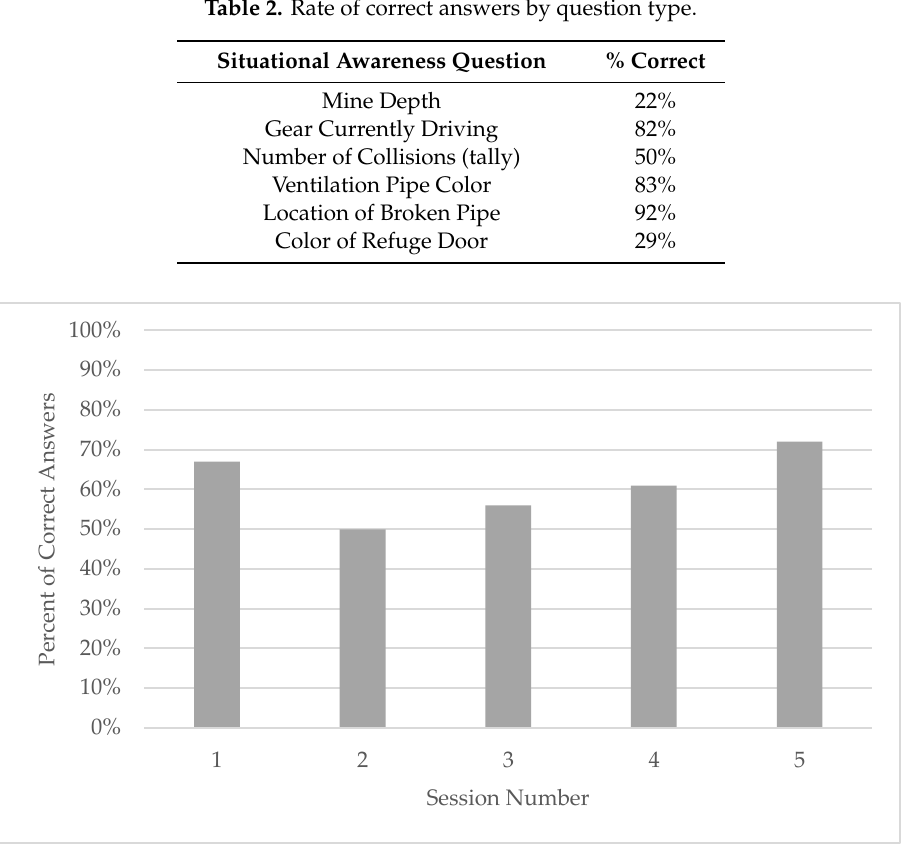
Figure 5. Rate of correctly answering situational awareness questions as a function of sessions.